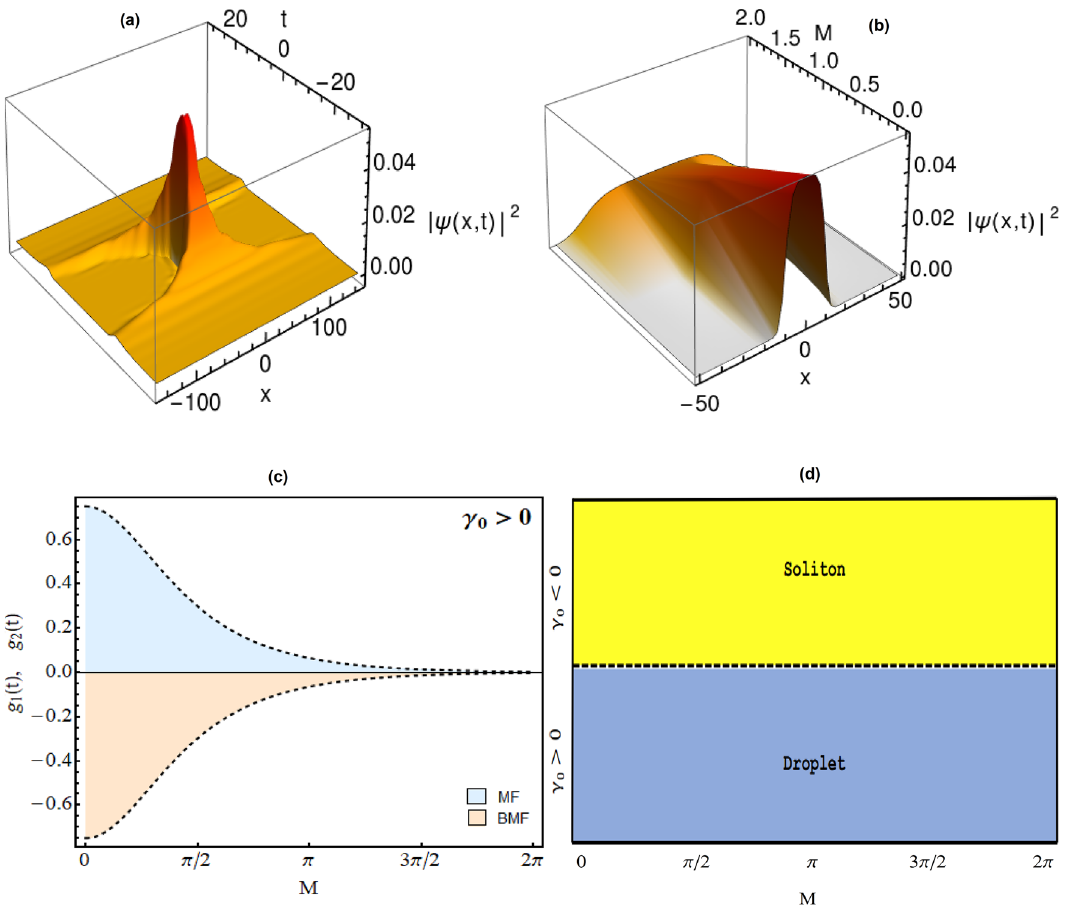
Figure 5. Quantum droplet dynamics in expulsive harmonic trap. The compression of condensate density 0.25 , and (b) oscillator frequency M at t 1 for the dimensionless parameter values: w.r.t. (a) time ( t ) for M = = 1 , G 2 0.999999 . For the same parameter values, the variation of g 1 ( t ) (light 1.5 , E 2 / 9 , G 1 γ 0 = − = = = − 1 are depicted in (c). (d) Phase diagram orange filled region) and g 2 ( t ) (light blue filled region) w.r.t. M at t = representing the droplet to soliton transition in between γ 0 and M in presence of expulsive trap. Figures are plotted using MATLAB R2020b (Master License 31349846) and Mathematica version 1.5.1.2021061827, Wolfram Research, Inc.